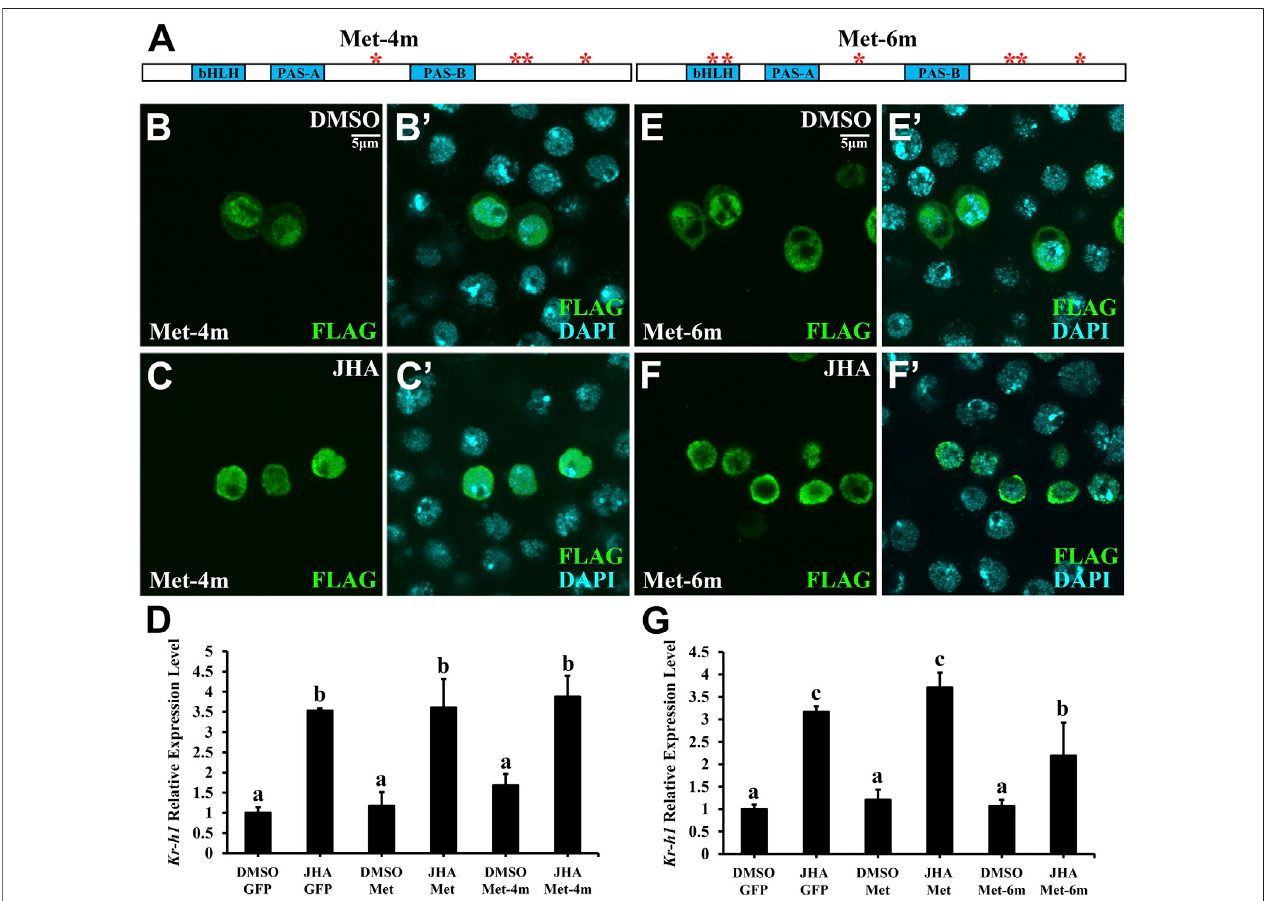
FIGURE5| Phosphorylationsites inthebHLHbut notthePAS-B domain promote JHsignalingactivity. (A) AschematicdiagramshowingthemutationsoftheThr and SerresiduesinMet. (B – C ’ ) SubcellularlocalizationofMet-4minKccellstreatedwithJHAfor1 h,compared withthatintheDMSO control. (D) Effect ofGFP,Metor Met-4moverexpressioninKccellsonKr-h1mRNAlevelat2 haftera10 μ MJHAtreatment. (E – F ’ ) SubcellularlocalizationofMet-6minKccellstreatedwithJHAfor1 h, comparedwiththatintheDMSOcontrol. (G) EffectofGFP,MetorMet-6m overexpression inKccellsonKr-h1mRNAlevelat2 haftera10 μ MJHAtreatment.For both panels (D) and (G) , different letters indicate signi fi cant differences using one-way ANOVA followed by Duncan multiple comparisons test.